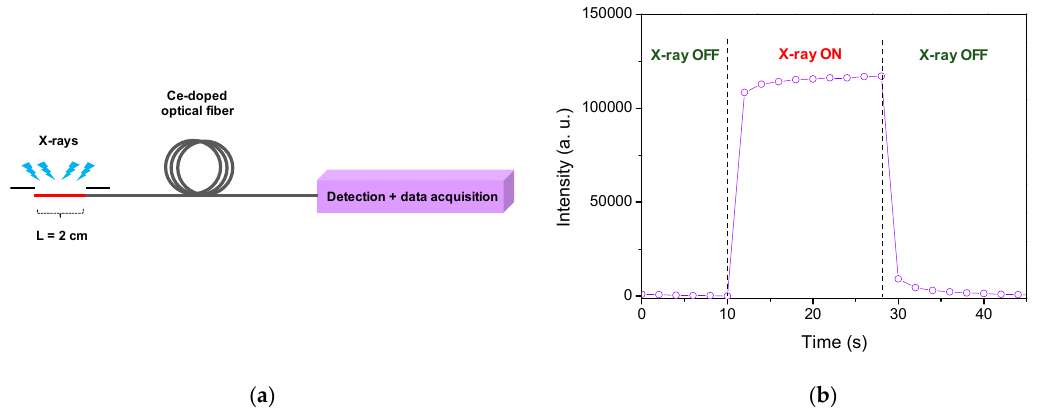
Figure 7. ( a ) Basic representation of the experimental setup used to evaluate the RL response of the Ce-doped optical fiber partially exposed to X-ray beam. ( b ) RL signal evolution versus time under 19.6 Gy(SiO 2 )/s dose rate.